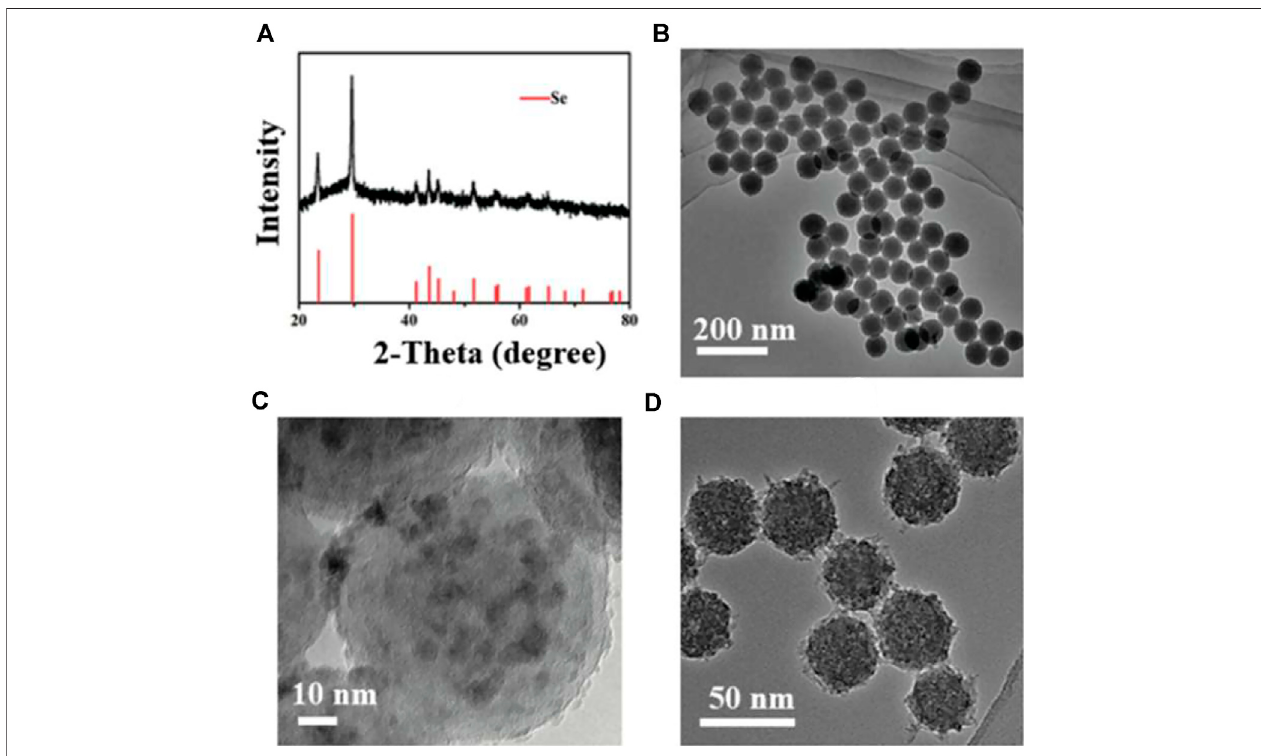
FIGURE 1 | Characterization of the Se@SiO 2 NPs. (A) The XRD spectra of the Se@SiO 2 NPs and the standard Se hexagonal phase (JCPDS card number: 65 – 1876). (B) Low- and (C) high-magni fi cation images of Se@SiO 2 nanoparticles. (D) TEM characterization of the synthetic Se@SiO 2 NPs. TEM microphotographs indicatedthestructureofSe@SiO 2 NPswhichconsistofaporoussiliconshellandencapsulatedSe.Abbreviations:Se@SiO 2 NPs,porousSe@SiO 2 nanoparticles;XRD, X-ray diffraction; TEM, transmission electron microscopy; Se,